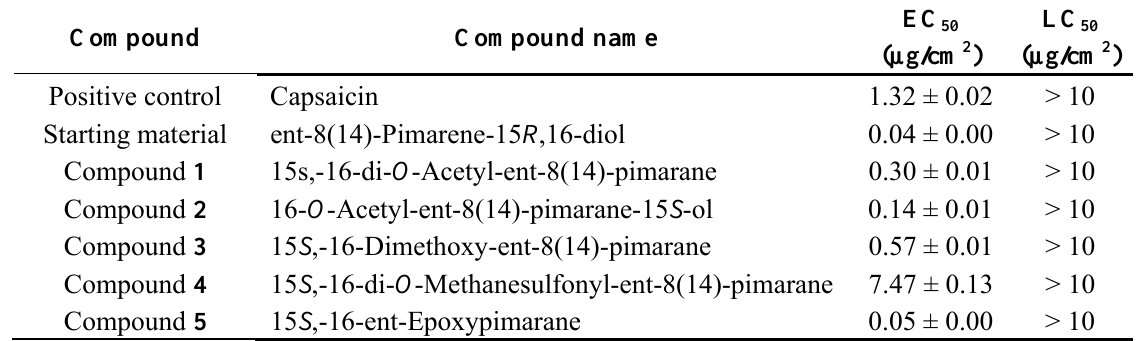
Table 1. Antifouling activity of the investigated compounds against B. albicostatus cyprid